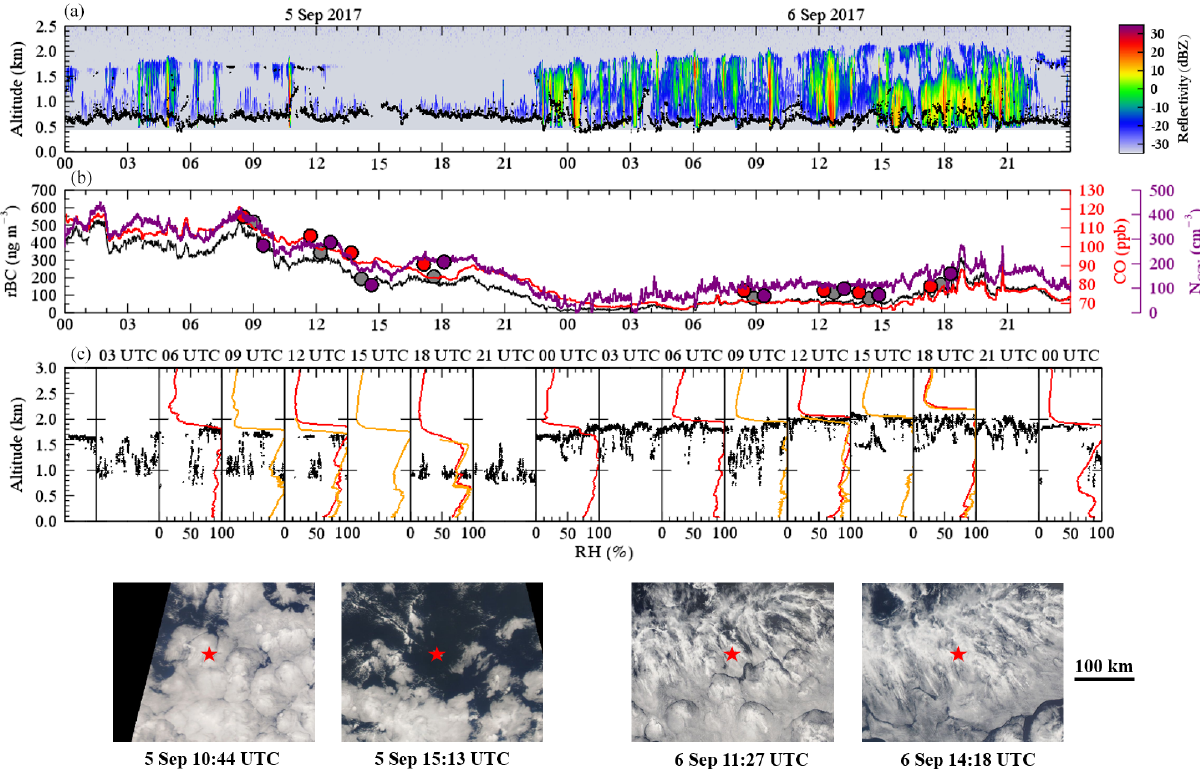
Figure 13. Observations from Ascension Island on 5 and 6 September 2017. Panel (a) shows radar reflectivity from the Ka-band zenith radar. Cloud base height measurements from the ceilometer are overlaid in black. Panel (b) shows measurements of the BC mass concentration, carbon monoxide and CCN concentration, made at the LASIC ARM site. Overlaid with filled circles are measurements from the FAAM aircraft made below 500m altitude during profiles in and out of Ascension Island. The aircraft PCASP concentration is used as a proxy for the CCN concentration. Panel (c) shows 3-hourly snapshots through the period. The black points are cloud top height estimates from the Ka-band radar taken from a ± 0.5h window around each 3h point. Overlaid are radiosonde (red) and aircraft profiles (orange) of relative humidity. MODIS true-colour satellite imagery around Ascension Island (red star) is also shown when available. The MODIS imagery was obtained from NASA